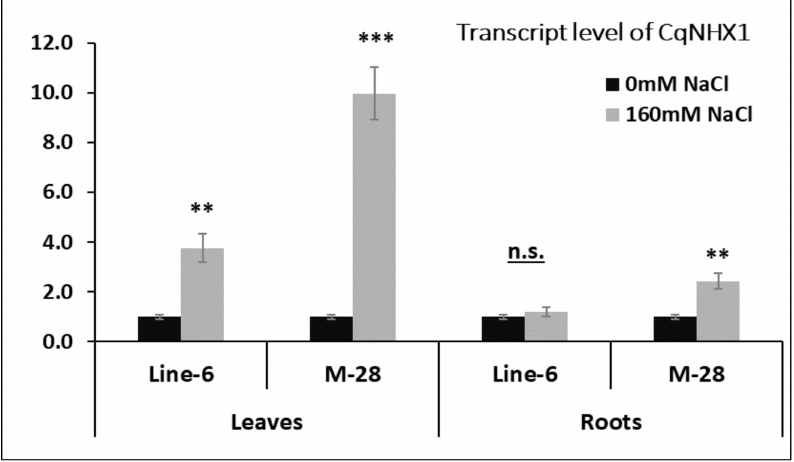
Figure 9. Expression analysis of CqNHX1 .Data represent leaves and roots of two quinoa genotypes. Twelve-day-old seedlings were gradually treated with 160 mM NaCl over six days. Results are presented as the mean fold-change in relative expression over the control from three biological and technical replicates, normalized to GAPDH (reference) gene expression. Bars represent standard deviation. **, *** Significant and highly significant at 0.01% probability